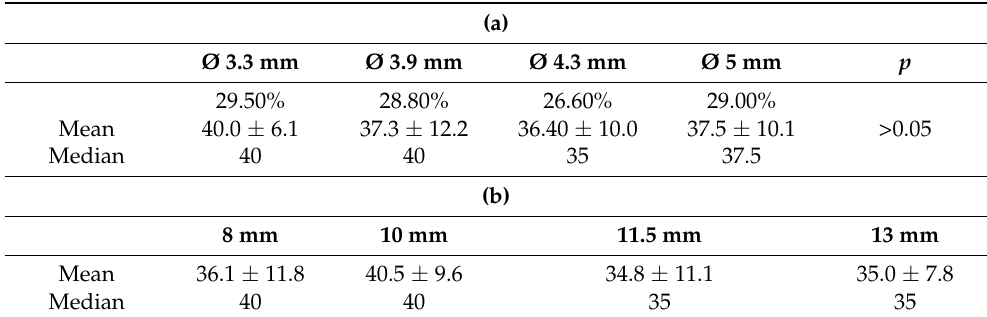
Table 2. ( a ) Insertion torque according to implant diameter given in Ncm. ( b ) Insertion torque according to implant length given in